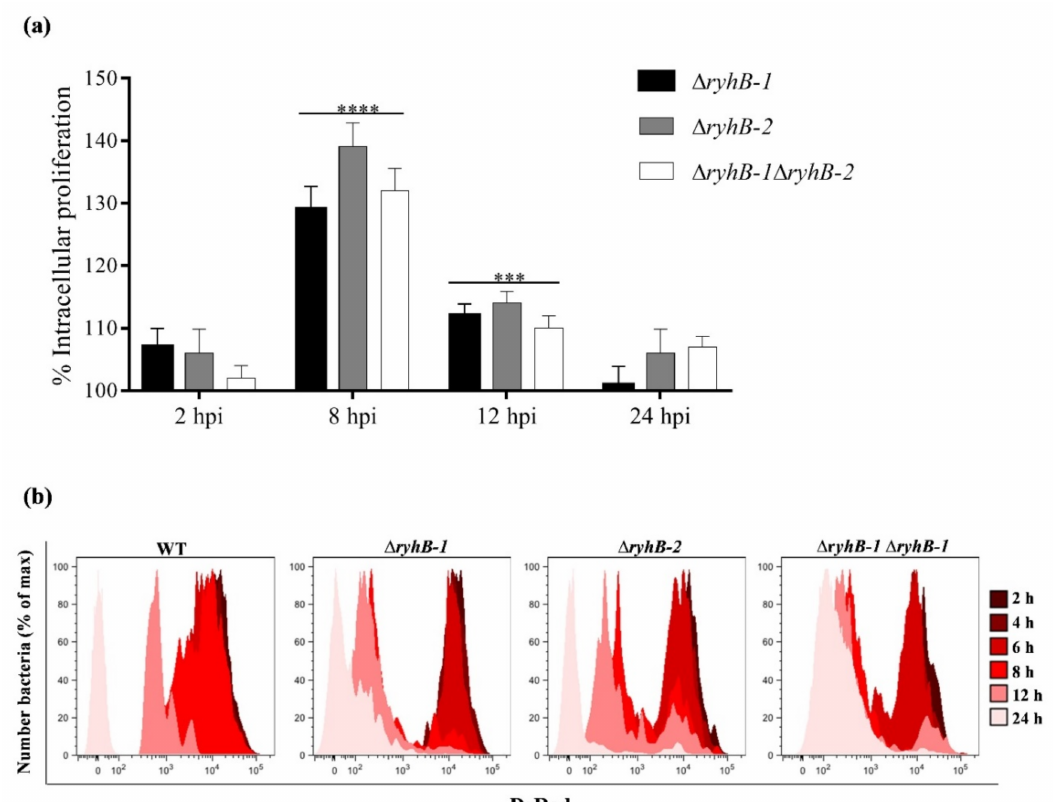
Figure 1. Intracellular proliferation of S. Typhimurium ryhB s mutants. RAW264.7 macrophages were infected with wild type (WT), ∆ ryhB-1 , ∆ ryhB-2 , and ∆ ryhB-1 ∆ ryhB-2 strains. ( a ) The number of intracellular bacteria was determined at the indicated hour post-infection (hpi) by plating serial dilutions of RAW264.7 lysates on Luria Bertani (LB) plates for counting CFU. CFU were counted in the initial inoculum and at the different hpi. CFUs were expressed as a percentage of the intra- cellular proliferation respect to the wild type (100%). Data represent the means ± standard deviations ( n = 3) (*** p = 0.0001; **** p < 0.0001). ( b ) S. Typhimurium replication in RAW264.7 macrophages determined by flow cytometric detection of DsRed and EGFP fluorescence at different hpi from the bacterial strains carrying the pDiGc plasmid ( n = 30,000 events analyzed at each time